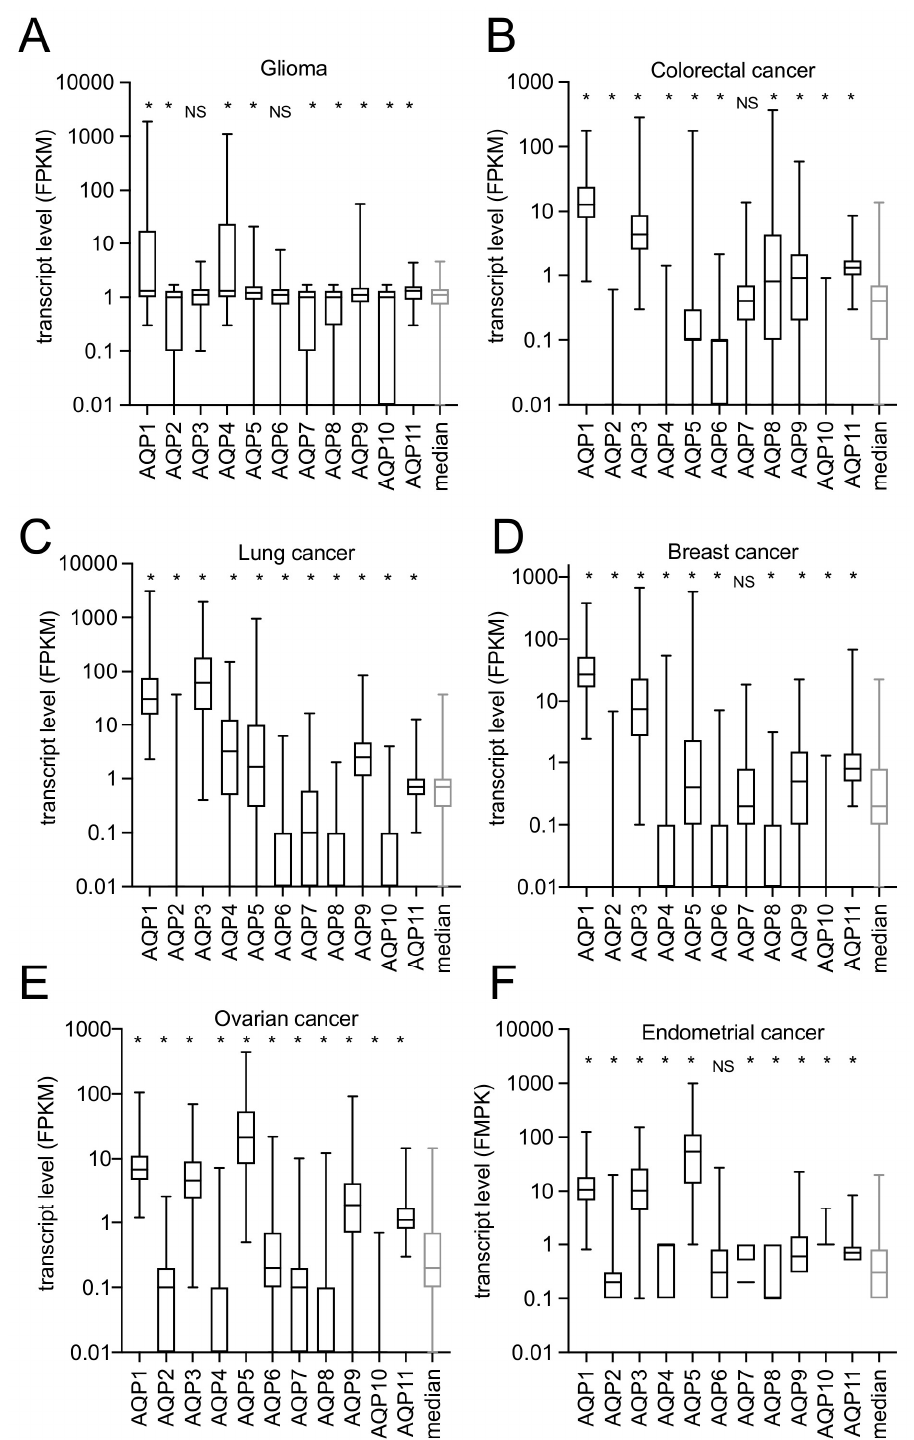
Figure 3. Quantitative transcript levels in human cancer biopsies, calculated as “fragments per kilobase of exon per million reads mapped” (FPKM). Data from the RNAseq transcriptomic database (Human Protein Atlas, https: // www.proteinatlas.org), summarized by AQP class, are shown as box plots for six cancer types ( A – F , as indicated). Boxes show 50% of data points; error bars show the full range; horizontal bars show median values. Median transcript levels are average FPMK values for all classes of AQPs (1–11) within each cancer type. * p < 0.05 as compared with the median values (Mann Whitney U-test); NS is not significant.